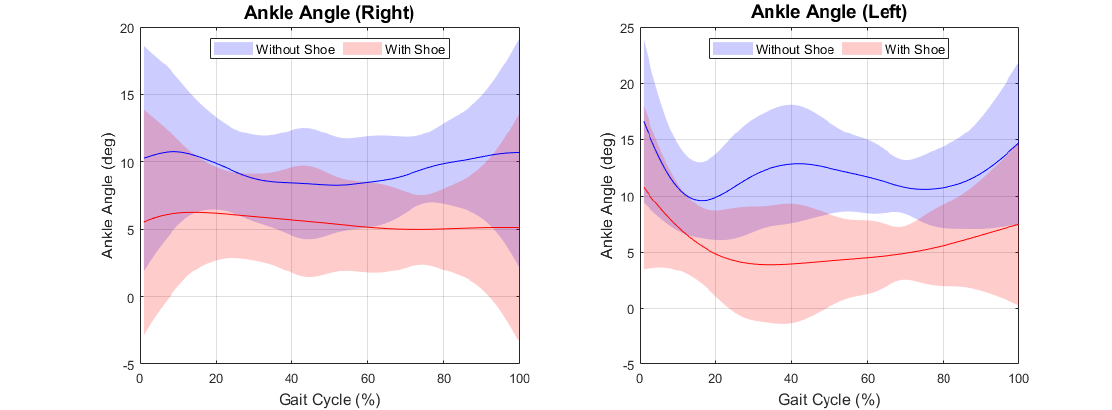
Figure 7. Ankle kinematics of flatfoot subjects with and without shoes. Red line indicates mean ankle joint angle with shoe group and Blue line indicated mean ankle joint angle without shoe group.